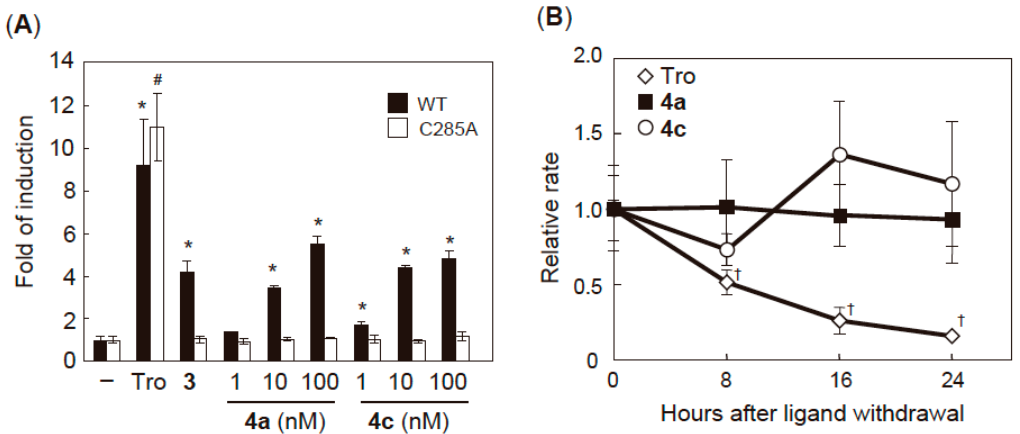
Figure 5. Characterization of the synthesized agonists 4a and 4c . ( A ) Mutation of the cysteine residue abolishes the PPAR γ agonist activities of 4a and 4c . The luciferase reporter assay was performed using wild-type and the C285A mutant of the pGal4-humanPPAR γ LBD plasmid. The experimental procedure was described in the caption for Figure 2. HepG2 cells were treated with the vehicle (0.1% DMSO, shown as –), troglitazone (10 μ M, shown as Tro), 3 (100 nM), 4a (indicated concentrations), or 4c (indicated concentrations) for 6 h. * p < 0.005, compared with vehicle control (WT). # p < 0.005, compared with vehicle control (C285A). ( B ) Monitoring the agonistic activities after ligand withdrawal. The luciferase reporter assay was performed using the pGal4-humanPPAR γ LBD plasmid. The experimental procedure was described in the caption for Figure 2. The transfected HepG2 cells were treated with troglitazone (10 μ M, shown as Tro), 4a (100 nM), or 4c (100 nM) for 6 h and then washed with media to remove the treated compounds. Cells were further cultured for the indicated times in the absence of ligands, after which the luciferase activities were measured. All the results are presented as the mean ± SD (n = 3) of three independent experiments. † p < 0.01, compared with 0 h after ligand withdrawal.